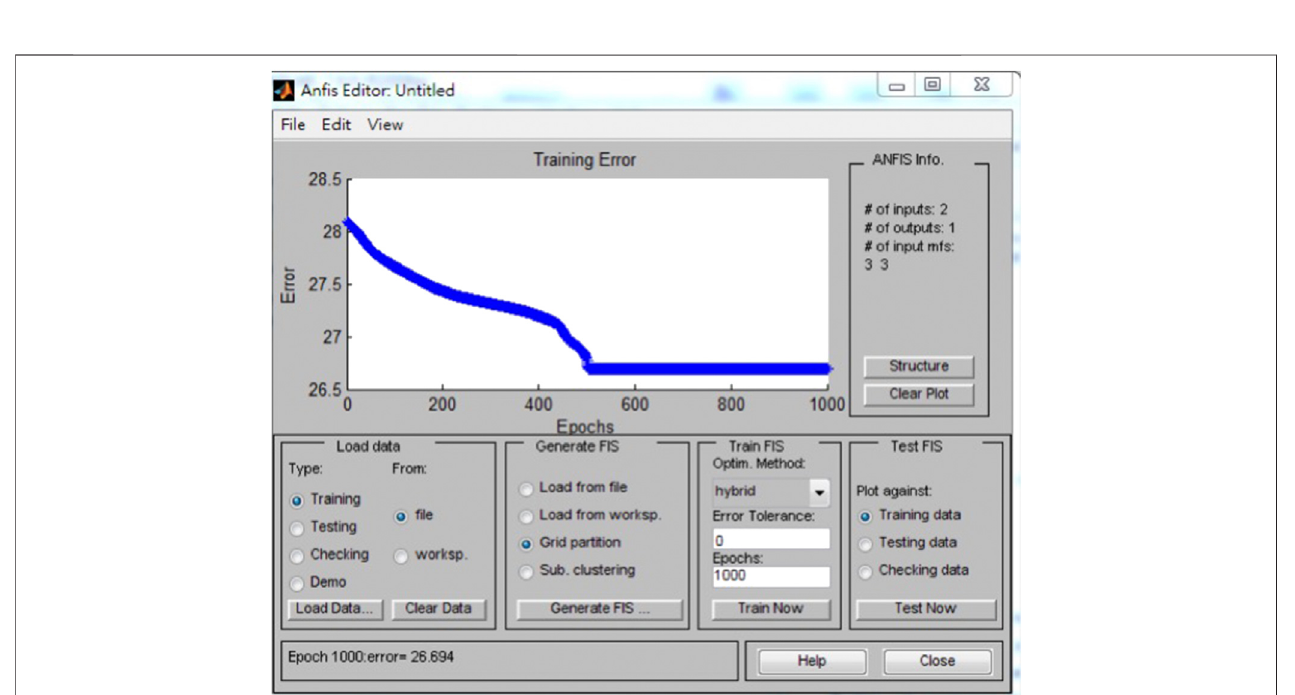
FIGURE 16 | ANFIS model training error.